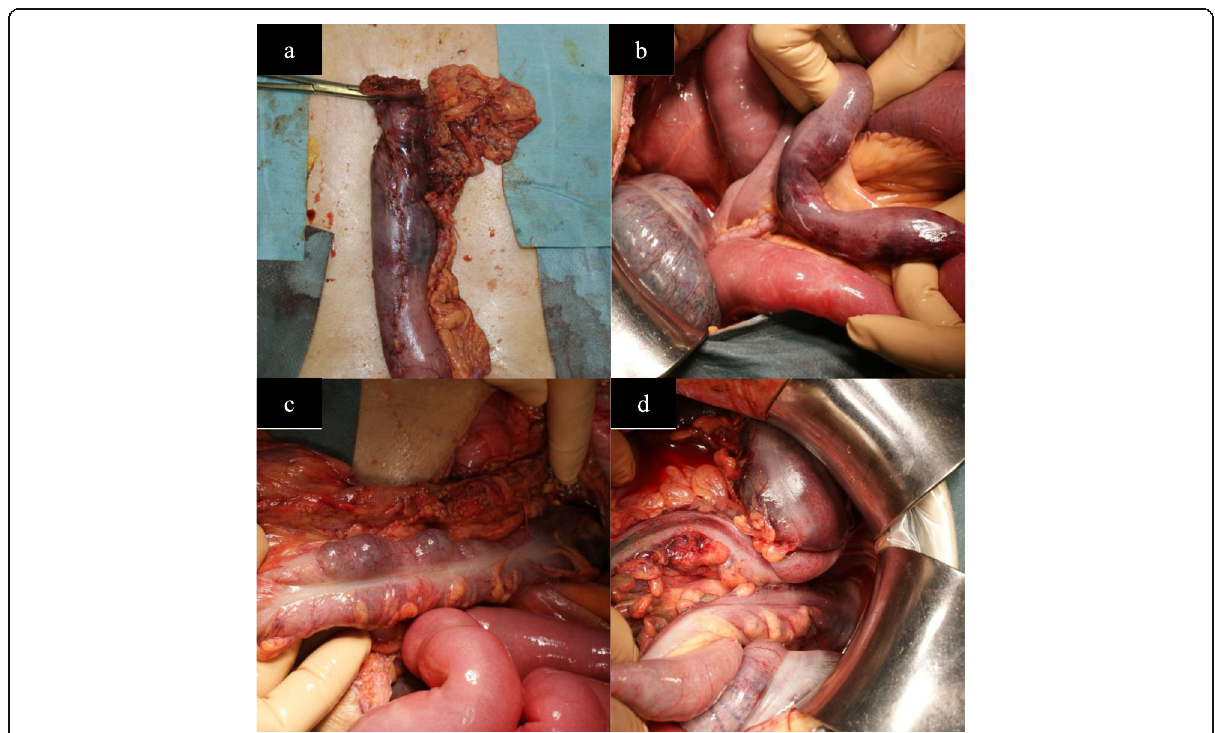
Fig. 3 Surgical findings at the second operation. a The color of the gastric conduit changed to purple, except for the antrum region. b The small intestine exhibited segmental ischemic changes. c Almost all of the colon, except for a part of the transverse colon, also exhibited necrotic changes. d Rectum near the peritoneal reflection was not preserved because of the ischemic change